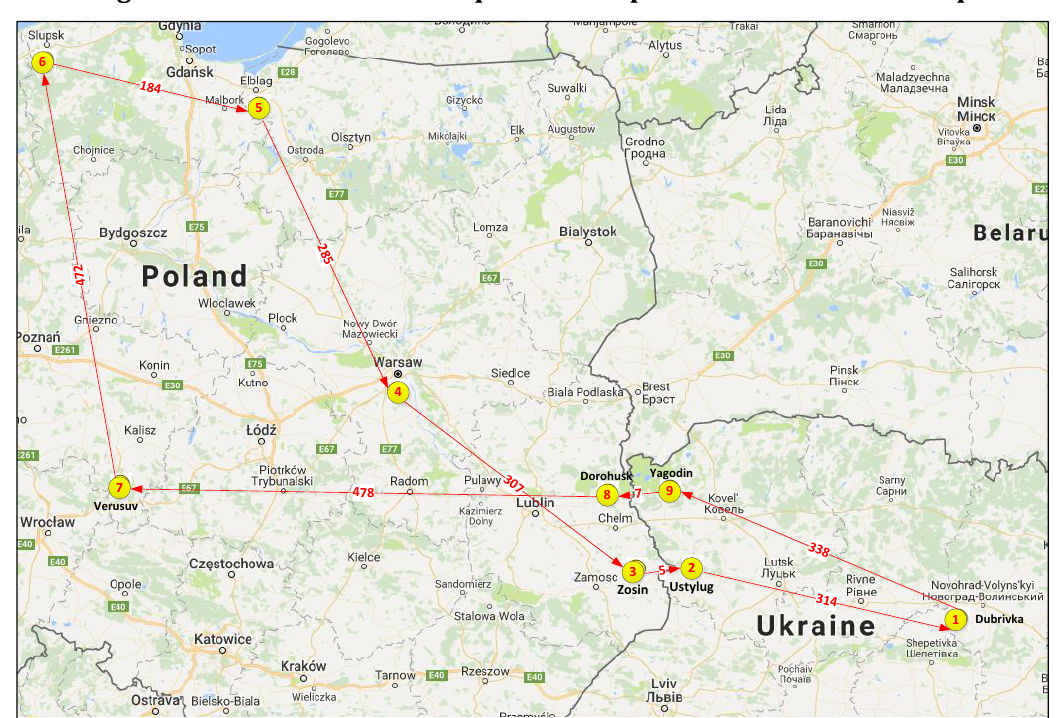
Figure 8: Presentation of the optimal transportation route on the